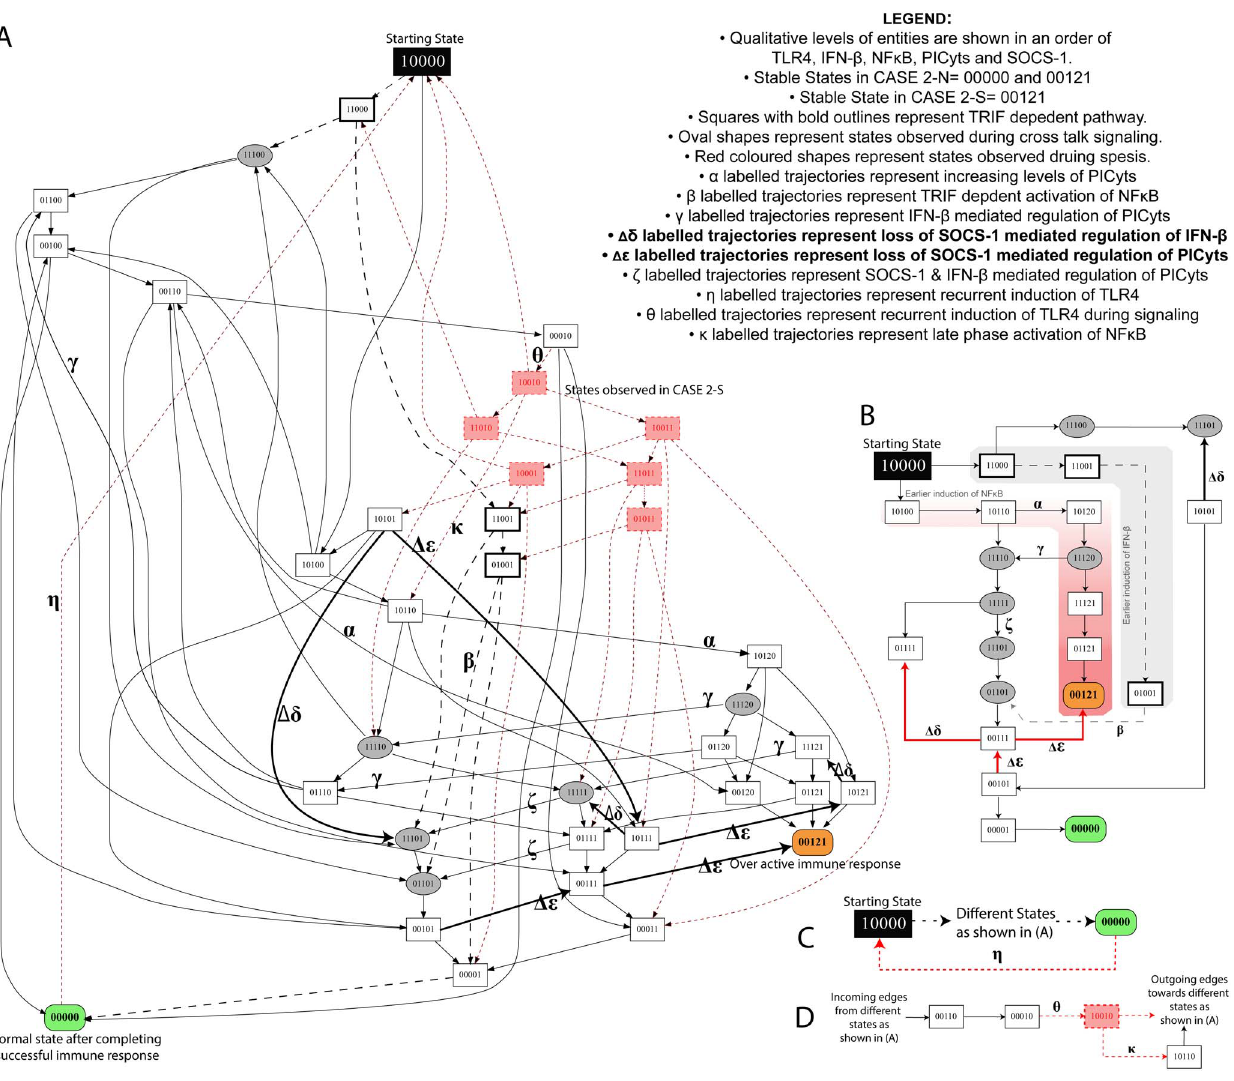
Figure 5. State graph of CASE 2-N and 2-S. (A) Each node represents a particular state observed during signalling associated with CASE 2-N and CASE 2-S. Integers ‘‘0’’, ‘‘1’’ and ‘‘2’’ within the nodes represent qualitative levels of proteins in the order of TLR4, IFN- b , NF k B, PICyts and SOCS-1. Inactive entities are represented by integer ‘‘0’’ whereas active and overactive entities are represented by integers ‘‘1’’ and ‘‘2’’, respectively. Nodes and trajectories, which were specifically observed during signalling dynamics associated with CASE 2-S, are shown in red, whereas common nodes and trajectories found in both CASES are shown in black. Trajectories start from state ‘‘10000’’, representing the activation of TLR4 and ultimately lead towards ‘‘00000’’ and ‘‘00121’’, which are stable states in CASE 2-N. On the other hand, only one stable state ‘‘00121’’ was observed during signalling dynamics associated with CASE 2-S and a trajectory labelled with ‘‘ g ’’ from state ‘‘00000’’ to starting state ‘‘10000’’ results in cyclic path. Trajectories associated with loss of SOCS-1 mediated downregulation of PICyts in CASE 2-N and CASE 2-S are presented as bold arrows labelled with symbol ‘‘ De ’’ whereas loss of SOCS-1 mediated downregulation of IFN- b are labelled with symbol ‘‘ Dd ’’. MyD88 and TRIF dependent signalling are shown as black lines and dashed arrows, respectively. Nodes, which represent crosstalk of both signalling pathways i.e. IFN- b and NF k B with qualitative level ‘‘1’’ are presented in oval shapes. Arrows labelled with Greek small letters are used to represent trajectories associated with different signalling events (see legend in the figure). The conditions necessary to produce a state graph shown in the figure are given in Table 3. (B–D) specific states and trajectories which can possibly represent the complete state graph given in (A).